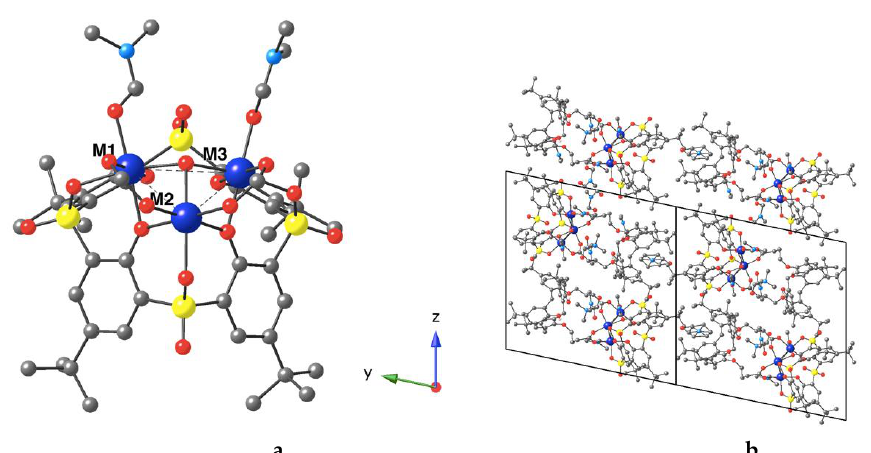
a b Figure 3. For M 3 (H 2 O)(DMF) 2 -( 2 -2H ) - 3 (M = Co II , Ni II and Zn II ): ( a ) view of the environment of the metallic cluster, and ( b ). view of the packing in the yOz plane. H atoms (except for the protonated phenol O atoms of ( 2 -2H) 2 − µ 3 -O from the coordinated water molecule) and solvent molecules (except for coordinated DMF molecules) are omitted for clarity In the unit cell, the metallic complexes are parallelly stacked along the a and b axes, as shown in Figure 3b. Disordered DMF molecules are encapsulated in the cavities formed by cone ligands ( 2 - 2H) 2− and 3 4− by van der Waals interactions, as shown in Figure 4. For Zn 3 (H 2 O)(DMF) 2 -( 2 -2H ) - 3 , water molecules are present with O-O distances of 2.6687 (140) and 3.1517 (169) Å , demonstrating the hydrogen bonds between H 2 O and DMF molecules. There are no specific interactions between the isolated discrete trinuclear species.